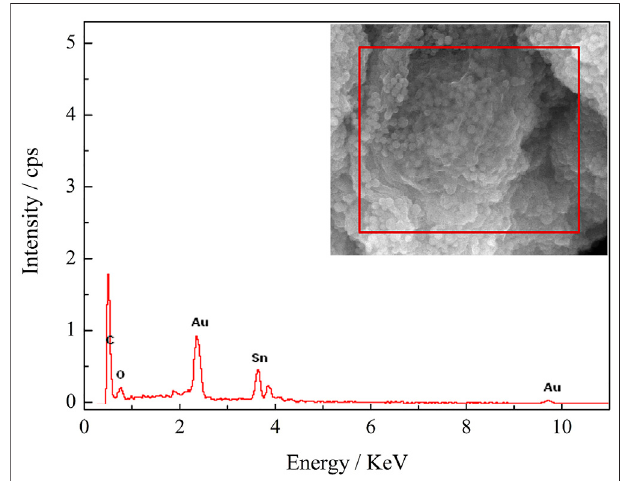
FIGURE 4 | Raman spectra of carbon spheres/graphene, SnO 2 / graphene, SnO 2 @C, and SnO 2 @C/graphene. FIGURE 5 | EDS image of SnO 2 @C/graphene.